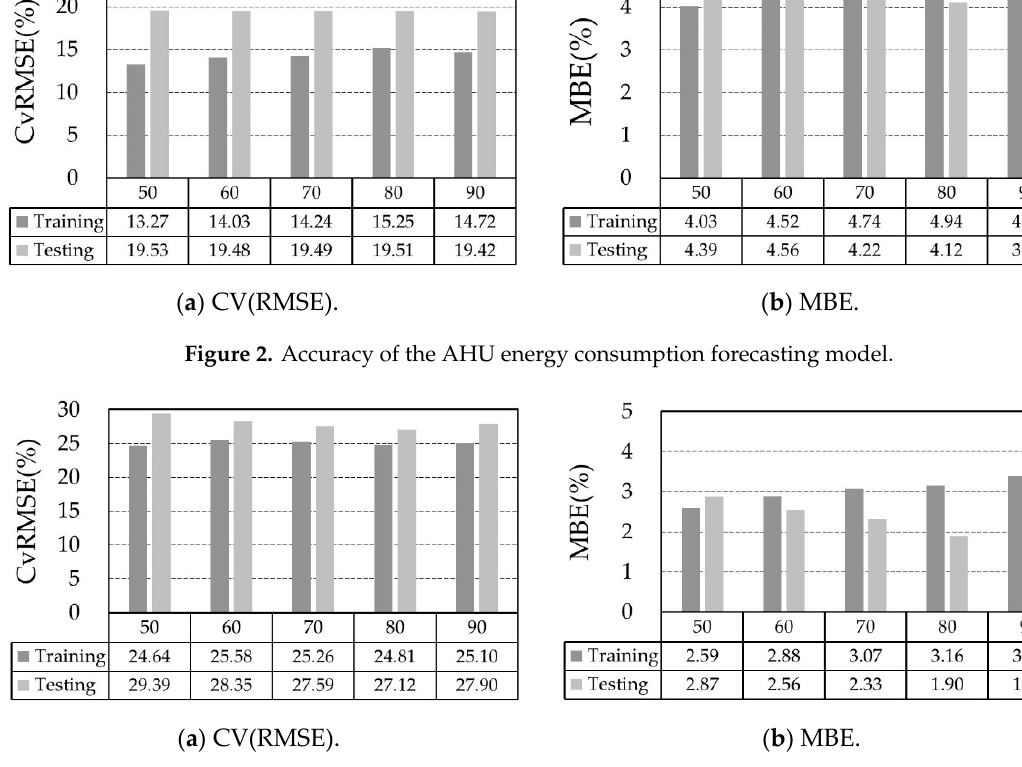
Figure 3. Accuracy of the absorption chiller energy consumption forecasting model.